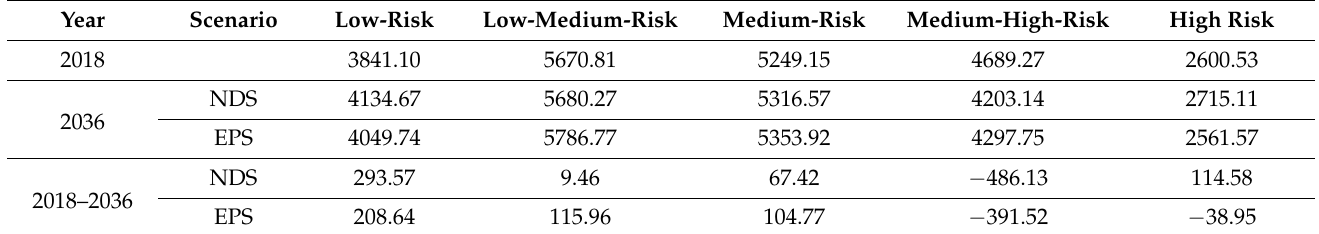
Table 5. Comparison of ecological risk level area under different scenarios (km 2 ).